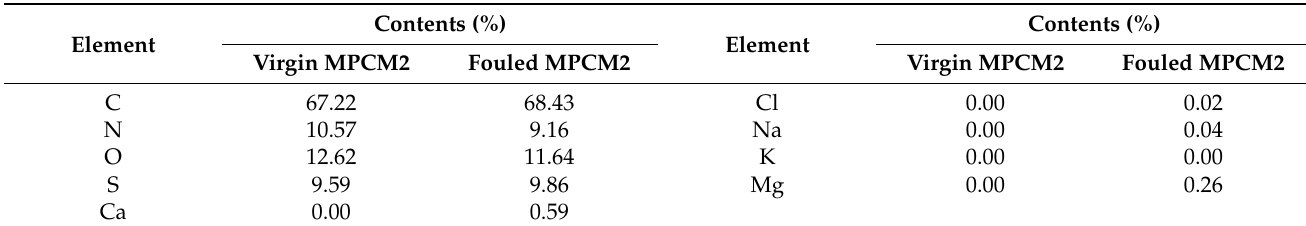
Table 1. Element compositions of the virgin and fouled membranes based on XPS